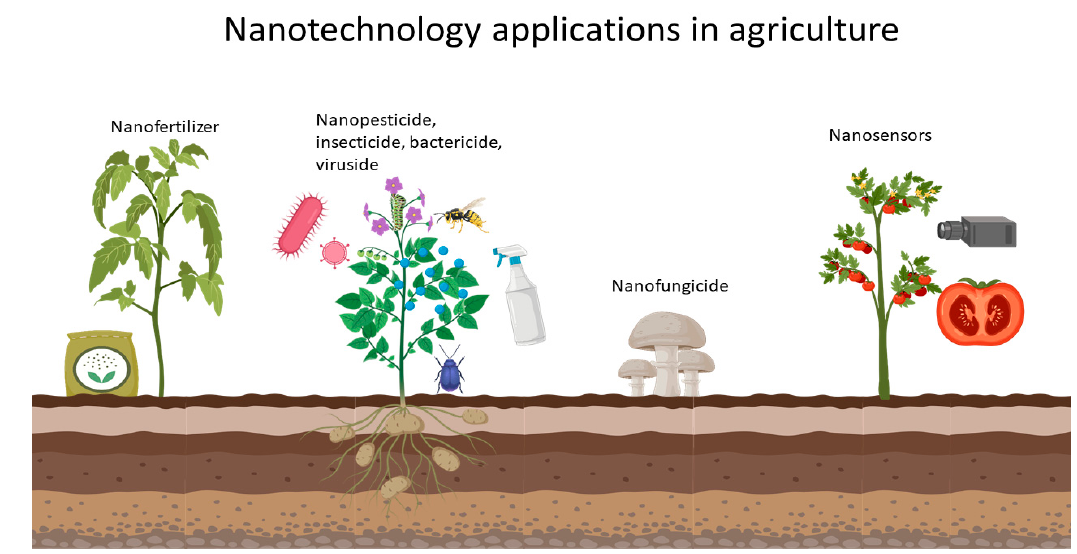
Figure 3. Nanotechnology applications in agriculture.